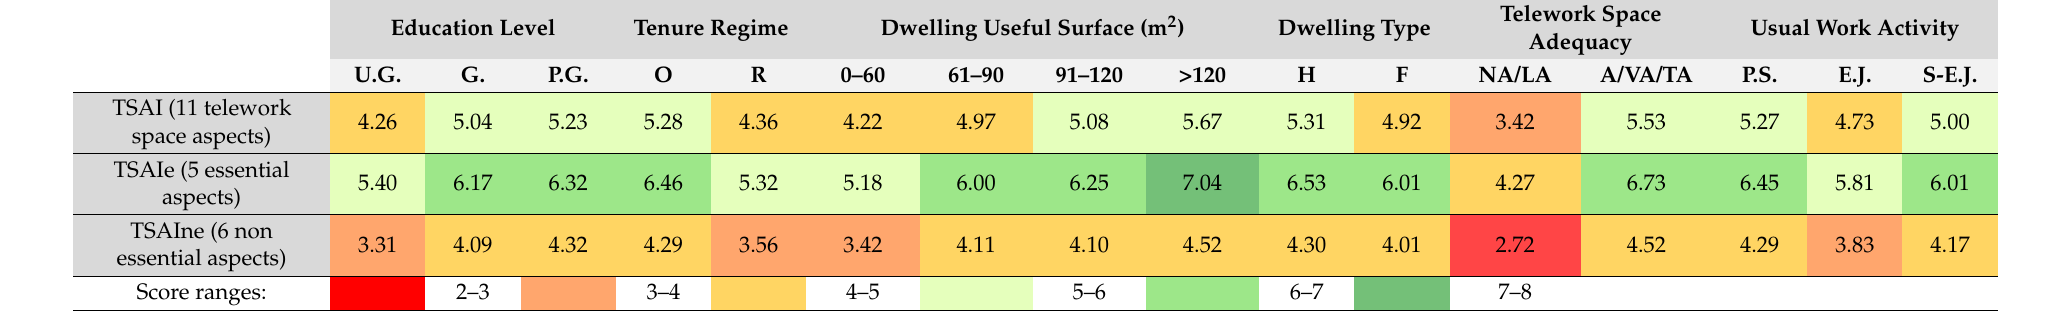
Table colors represent the TSAI score ranges, as showed caption added above. Acronyms: U.G.: Undergraduate; G: Graduate; P.G.: Postgraduate. O: Owned; R: Rented. H: House; F: Flat. NA: non adequate; LA: little adequate; A: Adequate; VA: very adequate; TA: totally adequate. P.S.: Public Servant; E.J.: Employed job; S-E.J.: Self-employed job. TSAIe: TSAI based on essential categories; TSAIne: TSAI based on non-essential